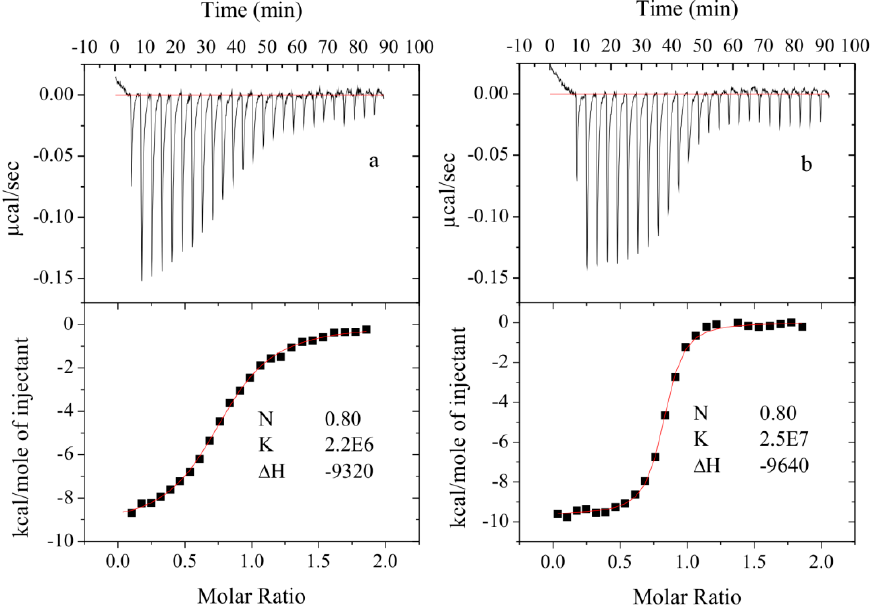
Figure 2. Calorimetric ITC titrations of CA II with 18 ( a ) and 31 ( b ). The experiments